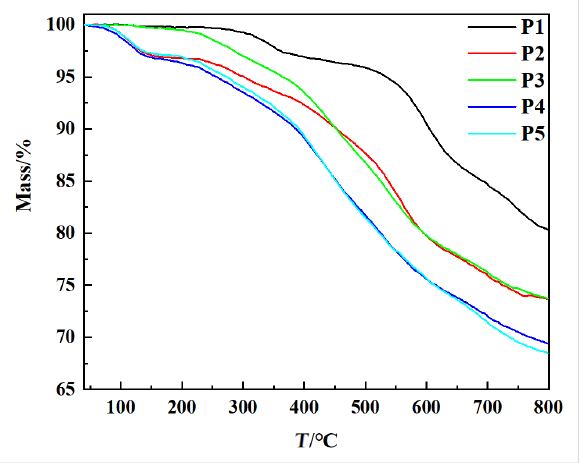
Figure 3: TGA curves of HCPs P1 – P5 .